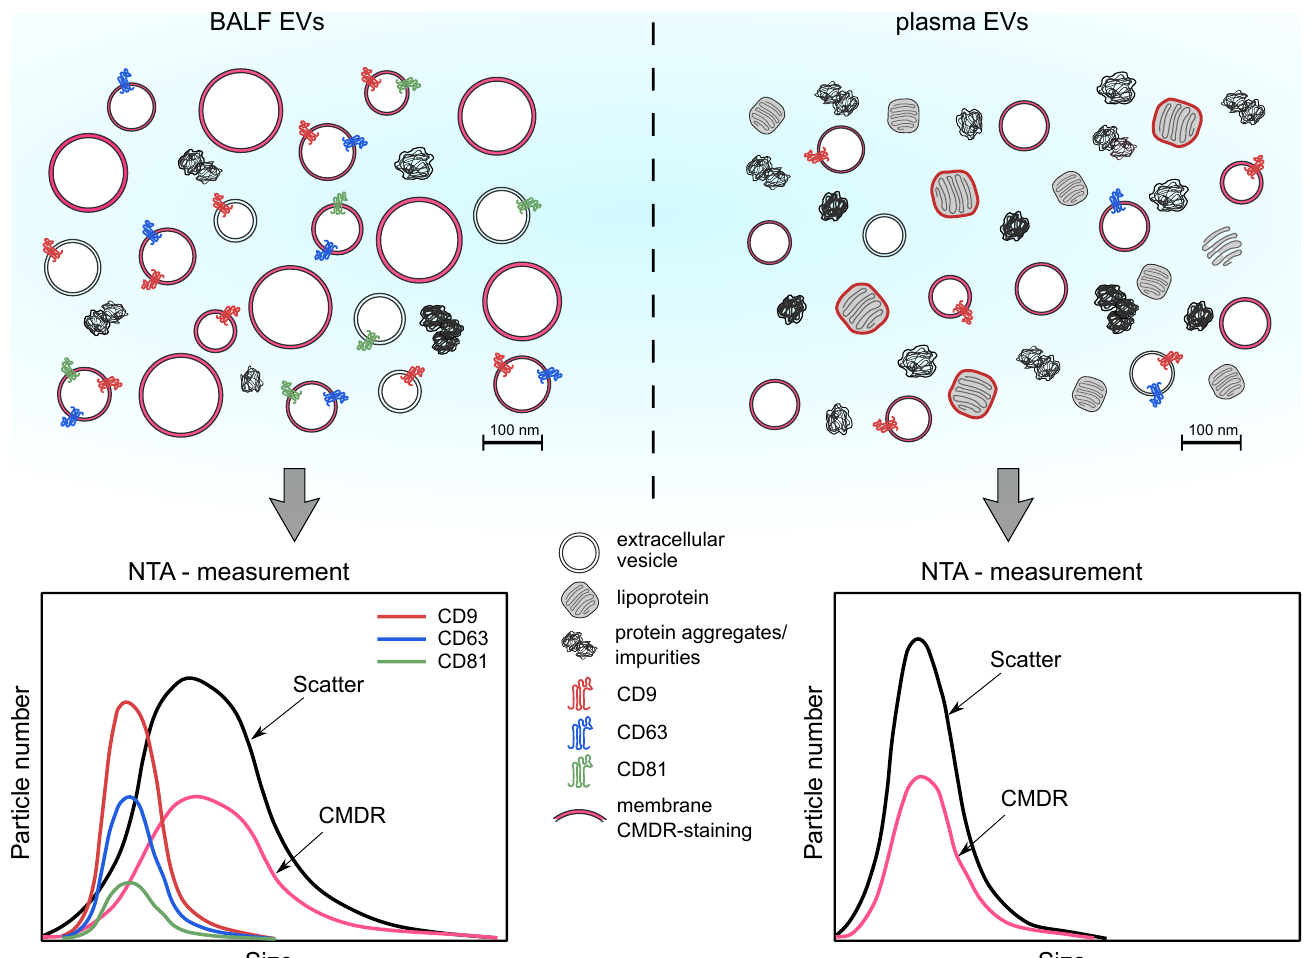
Figure 10. BALF and plasma EV characterization summary.